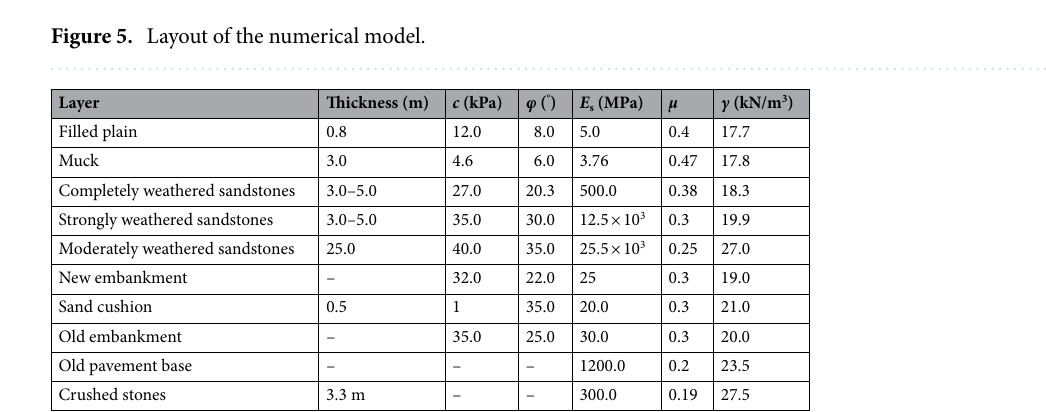
Table 4. Parameters of the numerical